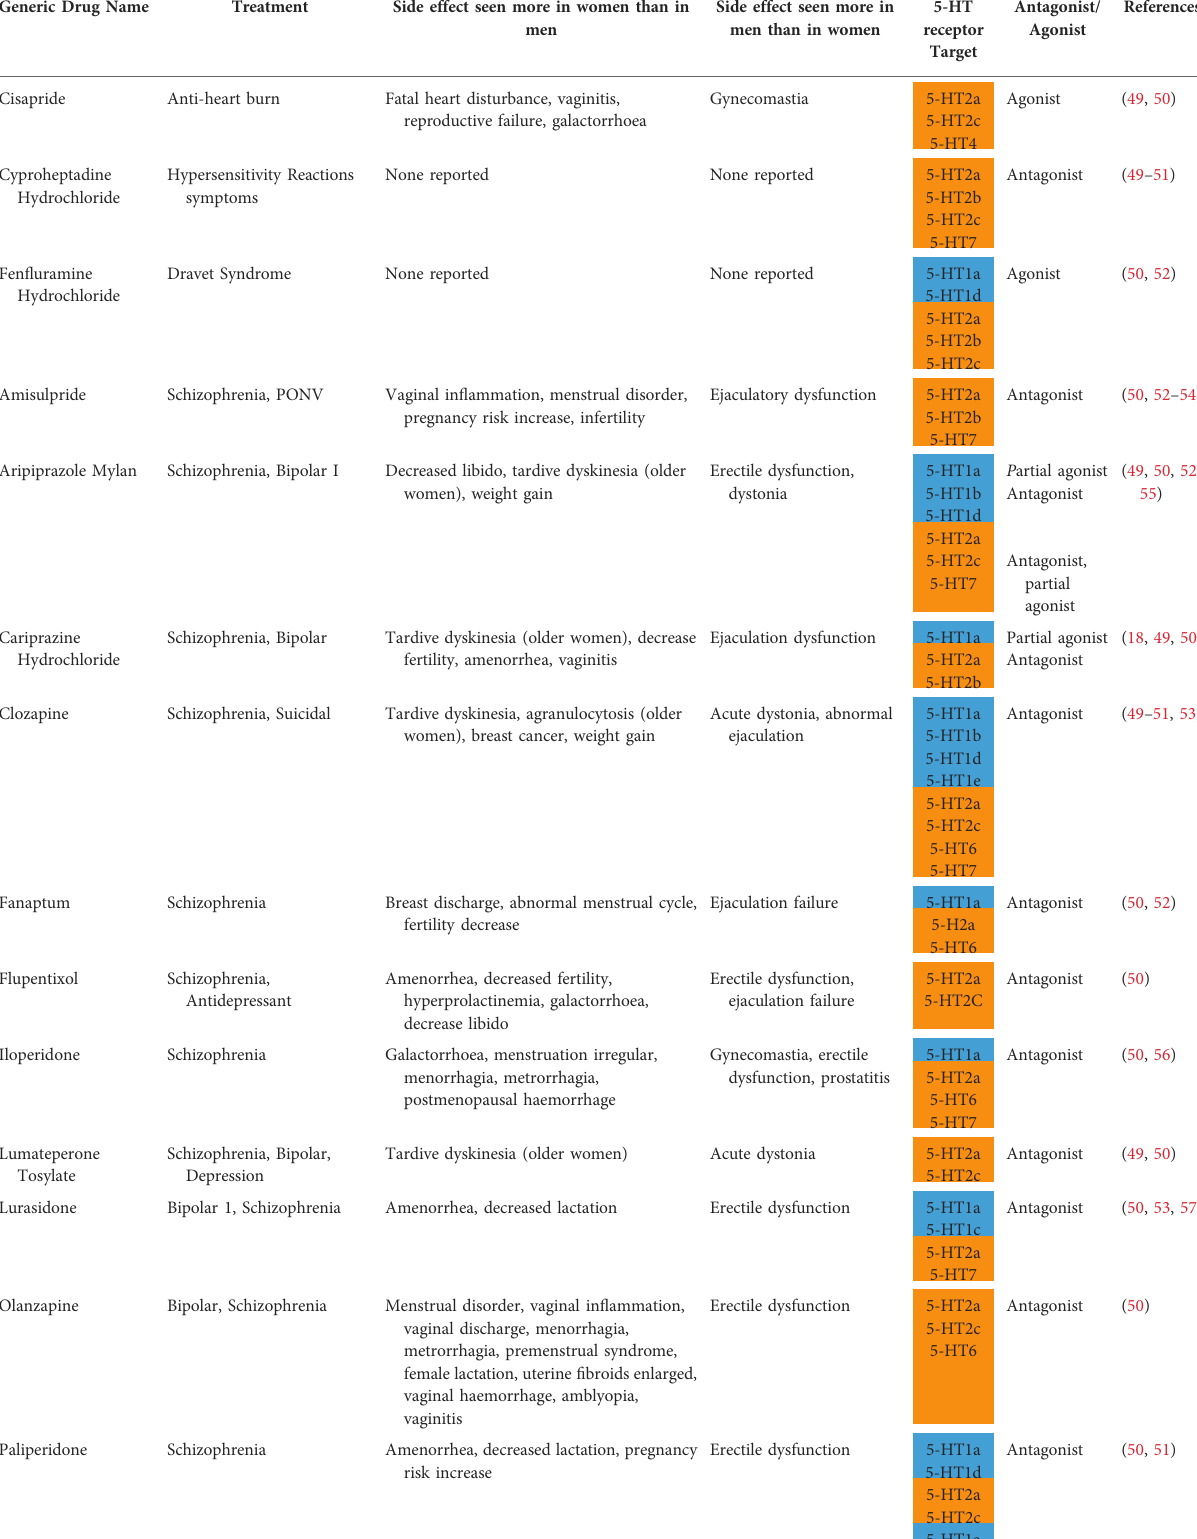
TABLE 2 Drugs used to treat psychiatric and neurological conditions that target serotonin receptors and their side effects in women and men. Data obtained from EMA and FDA drug approving bodies, SIDER and DrugBank. Abbreviations: MDD, multiple personality disorder; OCD,